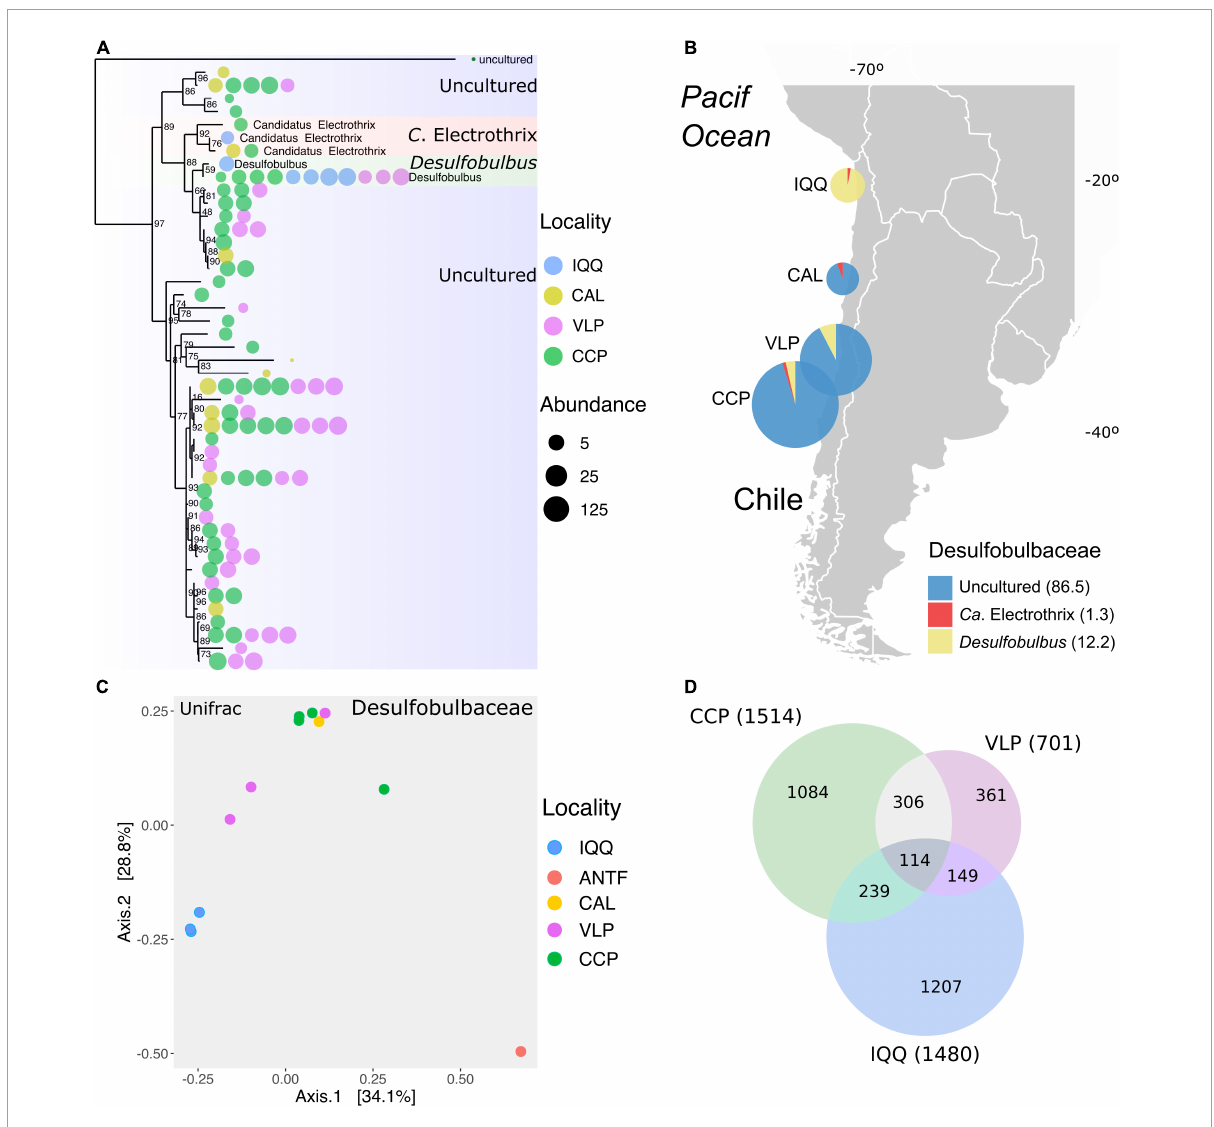
FIGURE4 (A) Phylogenetic tree of the representatives of the family Desulfobulbaceae identified across the data. The color and size of the bubbles indicate the presence and abundance of taxa by locality. (B) Distribution of genera of the family Desulfobulbaceae by locality in percentage (C) Non-metric multidimensional scaling (NMDS) based on the unifrac matrix distance of the abundance in the Desulfobulbaceae family (Stress = 0.0005). (D) Venn chart of shared and unique ASVs across all data by locality. The number in parentheses is the total